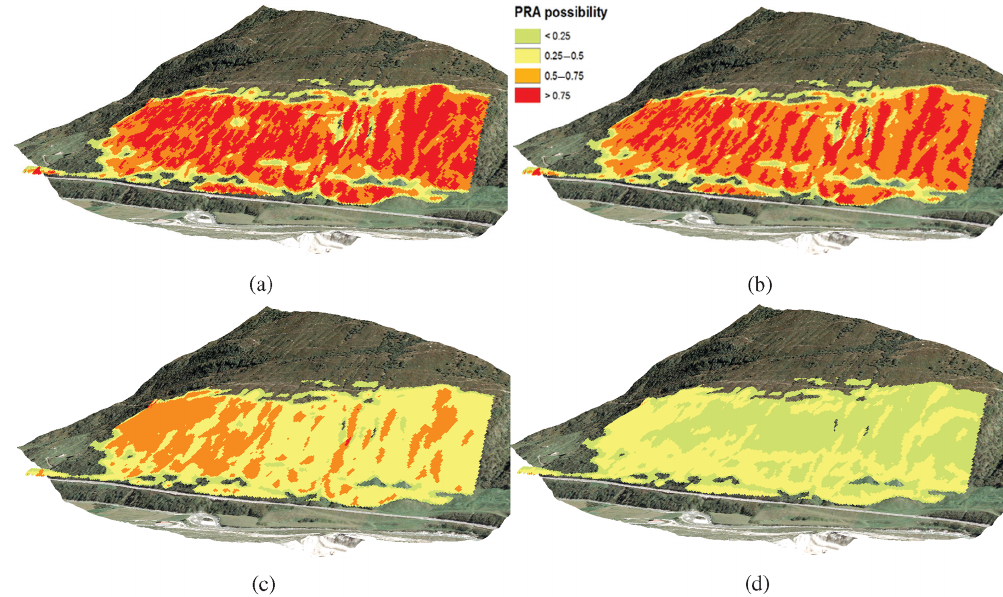
Figure 15. PRA possibility of (a) a southerly wind direction, (b) a southwesterly wind direction, (c) a westerly wind direction and (d) a northwesterly wind direction. Snow depth is set to